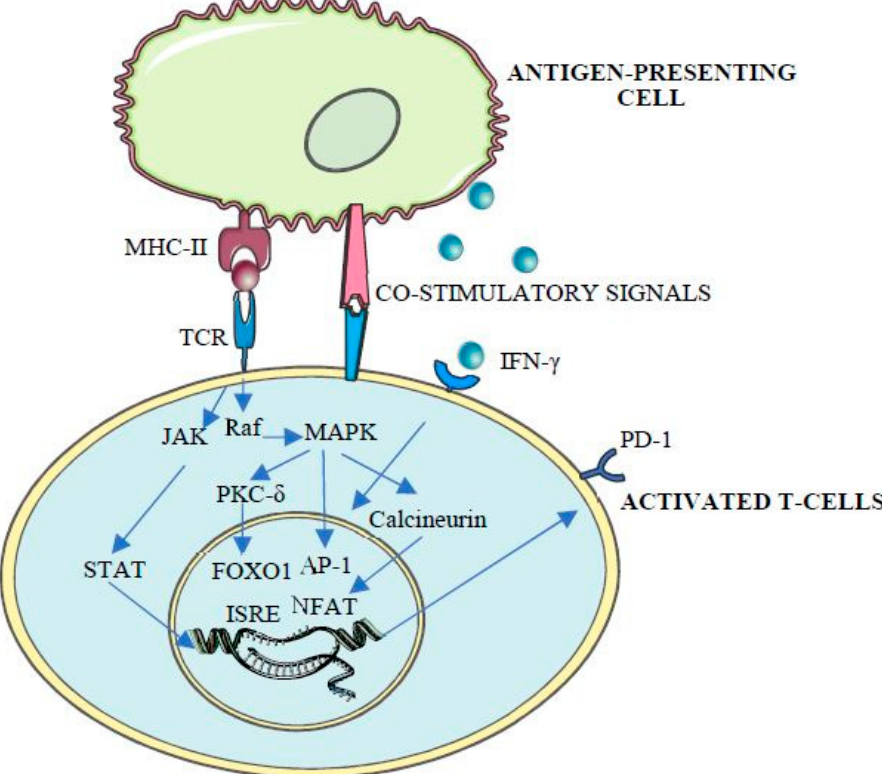
Figure 1. T-cell receptor (TCR) binding to antigen-loaded MHC-II triggers T-cell initial activation. TCR mediates protein kinase C (PKC) and subsequent Raf stimulation, leading to the activation of mitogen-activated protein kinase (MAPK) cascade and AP-1 phosphorylation, NFAT dephosphorylation by calcineurin, FOXO1 phosphorylation and activation by protein kinase C-delta (PKC- δ ) and JAK/STAT pathway activation, ultimately leading to PD-1 expression and T-cell activation [20].